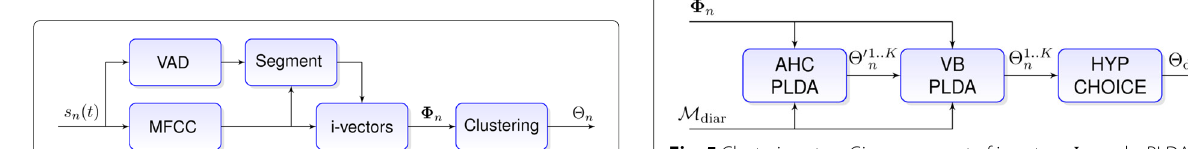
Fig. 5 Clustering step. Given some set of i-vectors (cid:4) n and a PLDA model M diar , diarization labels (cid:6) diar are